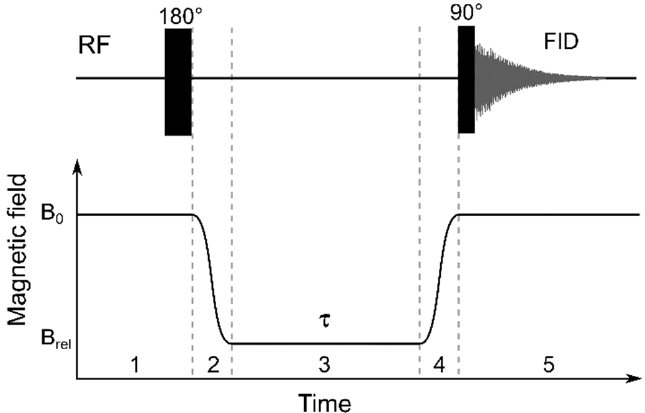
Figure 16. Five-step protocol for nuclear magnetic relaxation dispersion (NMRD) study, combining the high field magnetisation inversion recovery method ( B 0 = 16.4 T) (step 1) with fast field cycling in the variable magnetic field B rel (4 mT < B rel ≤ 16.4 T, step 2), remaining at B rel for a variable time interval τ (step 3) and returning to B 0 (step 4). The upper line shows radiofrequency (RF) pulses (at steps 1 and 5) for free induction decay (FID) detection synchronised with the mechanical shuttling of the NMR sample along the warm bore of the superconducting magnet of the NMR